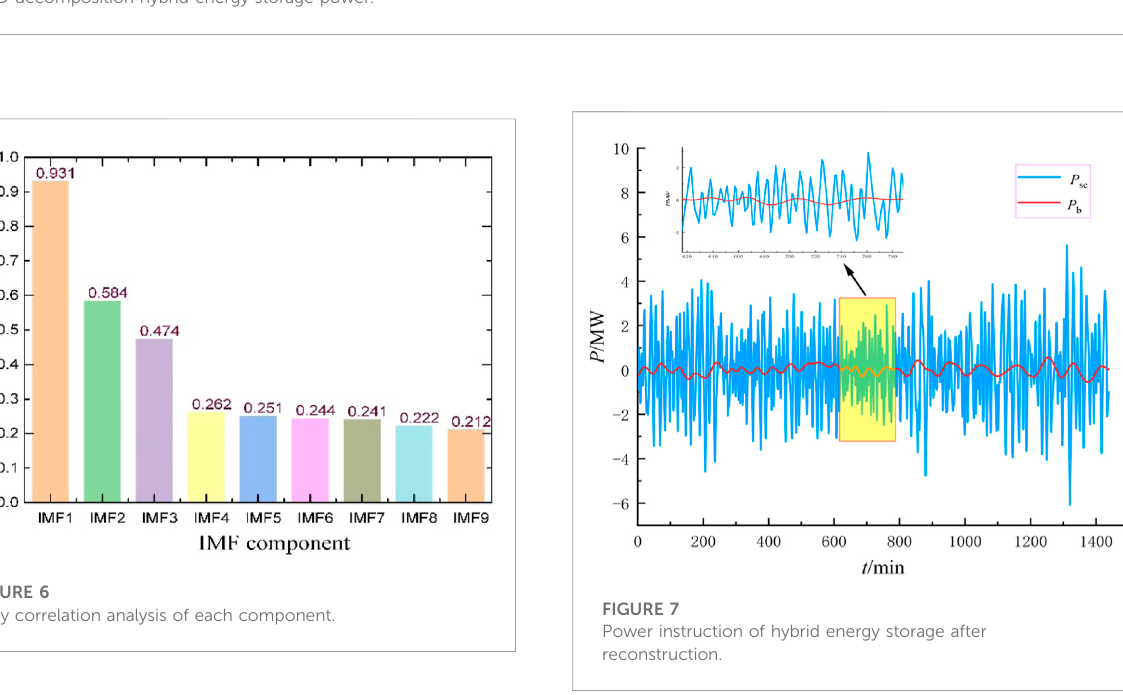
FIGURE 5 EMD decomposition hybrid energy storage power.